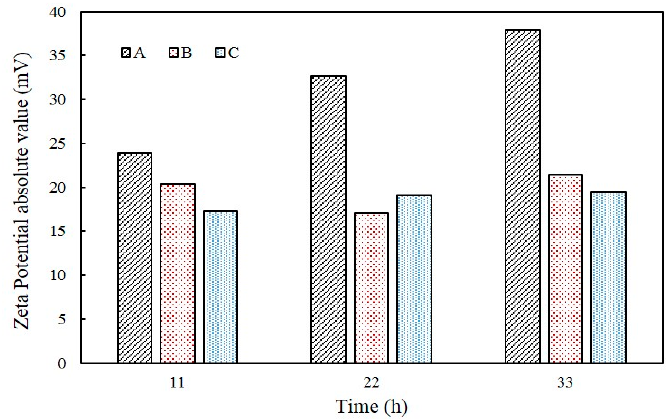
Figure 8. The changes of zeta potential in urea–calcium lactate medium over time.